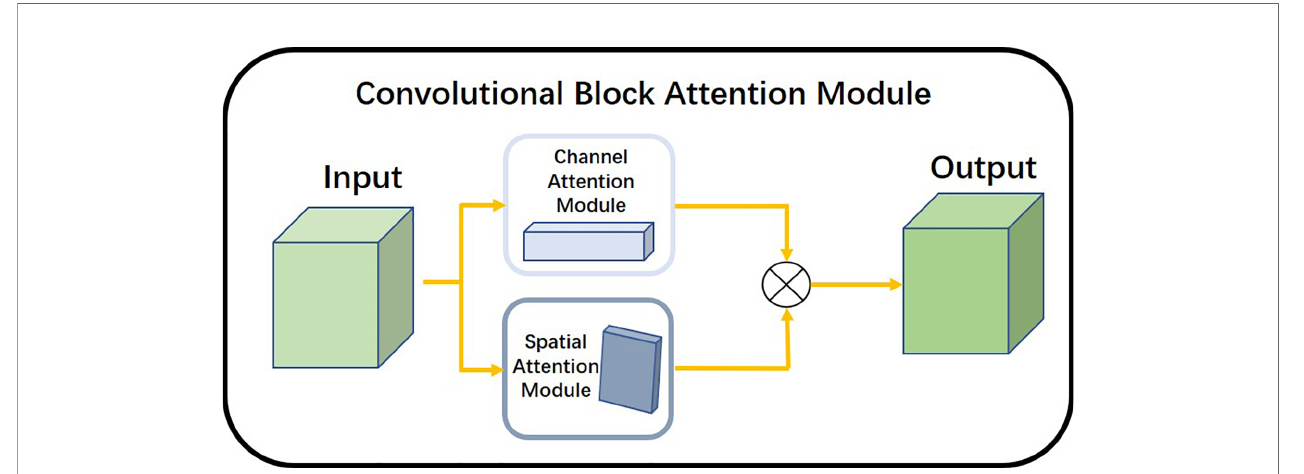
FIGURE 6 | Overall architecture of the attention